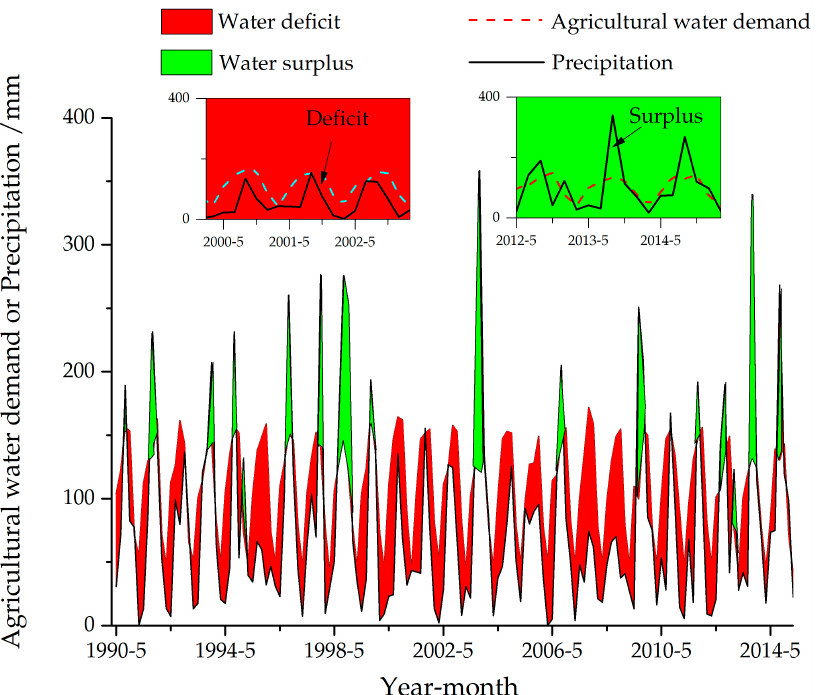
Figure 5. The difference of agricultural water demand and precipitation during May to October of each year from 1990.